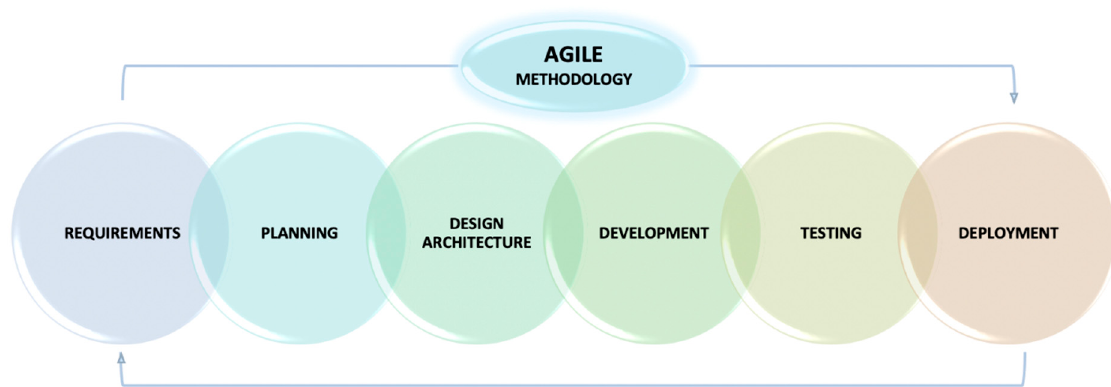
Figure 1. Agile methodology.